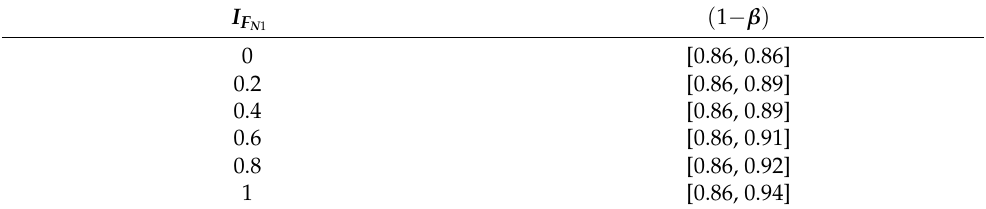
Table 4 . The values of the power of the test when 𝛼 = 0.05. Table 5. The values of power of the test when α = 0.01.